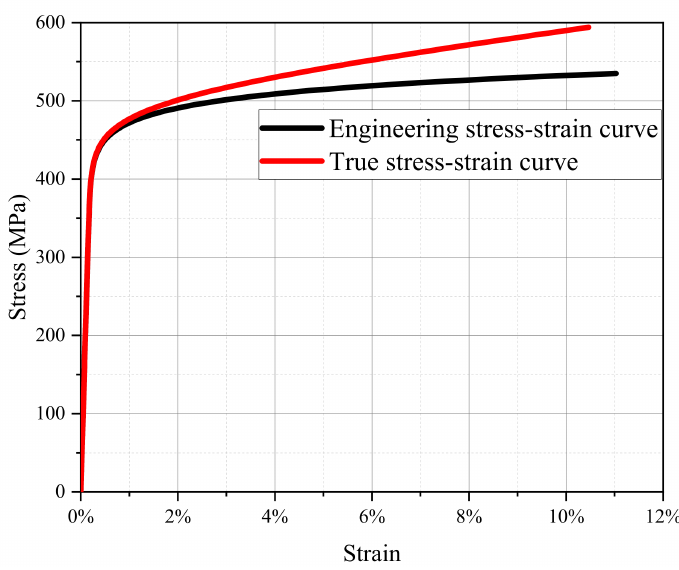
Figure 3. X65 line-pipe steel stress-strain